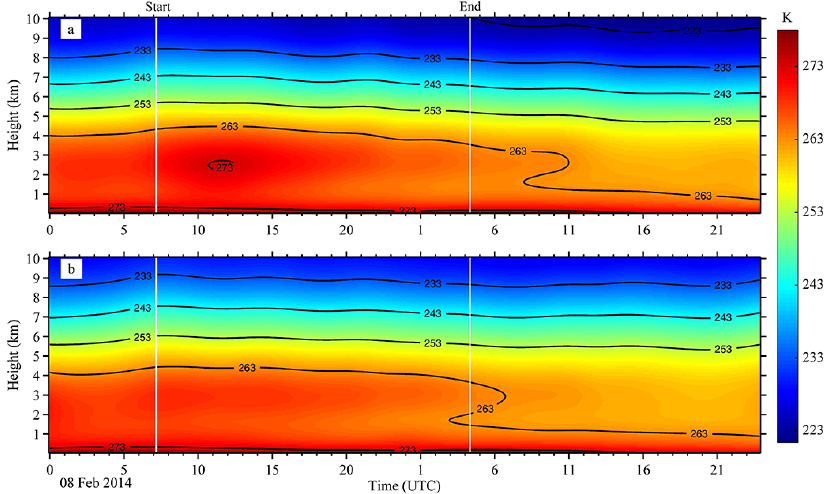
Figure 7. Comparison of temperature retrievals between zenith (a) and off-zenith (b) observation in light-snowfall condition. The start and end times of snowfall are indicated by the vertical lines. The time series starts at 00:00UTC on 8 February 2014.